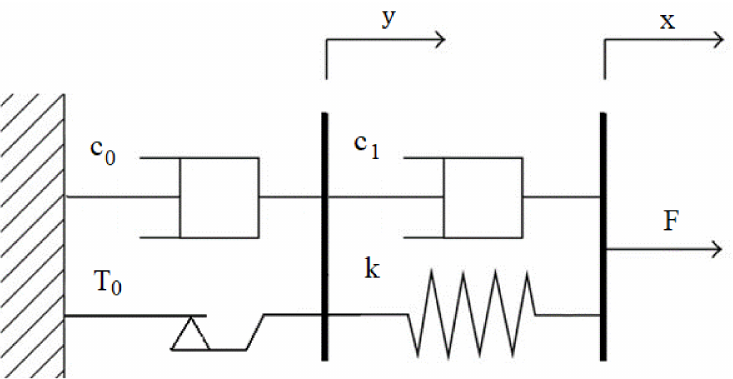
Figure 3. Rheological model of the MR damper; T 0 , c 0 , c 1 , k —model parameters, x, y —coordinates of the